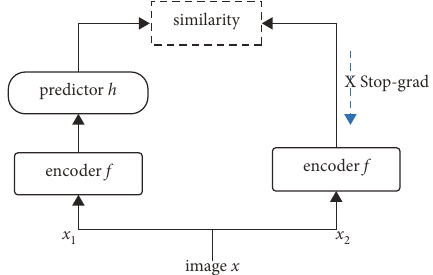
Figure 2: The architecture of SimSiam [24].